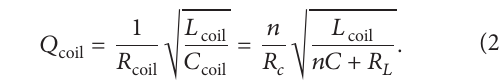
Figure 7: High frequency